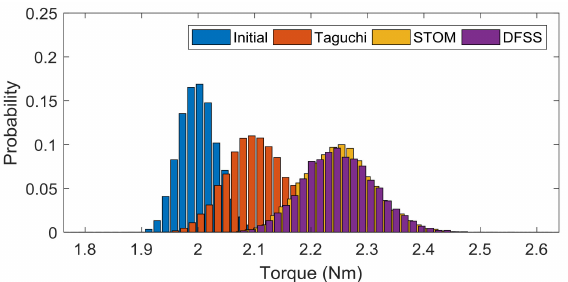
Figure 14. Distributions of output torque considering the manufacturing tolerances.